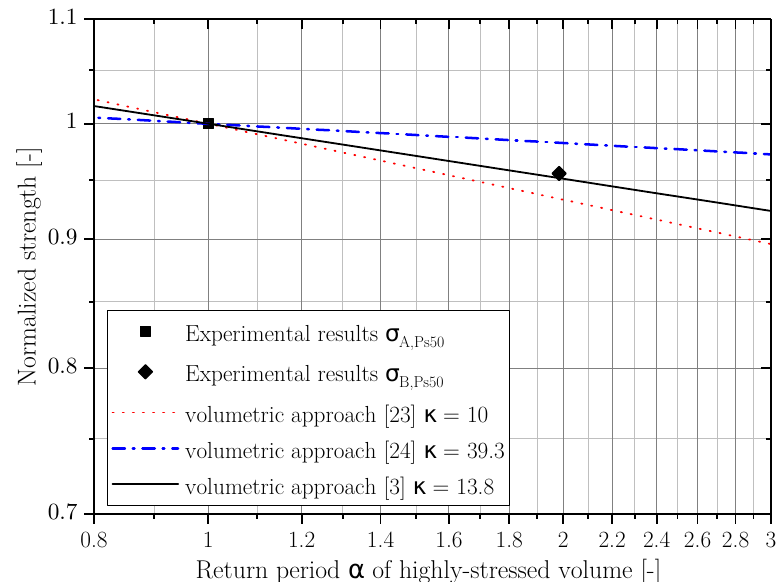
Figure 14. Comparison of HSV-based fatigue assessment models for S/N-results of specimen A and